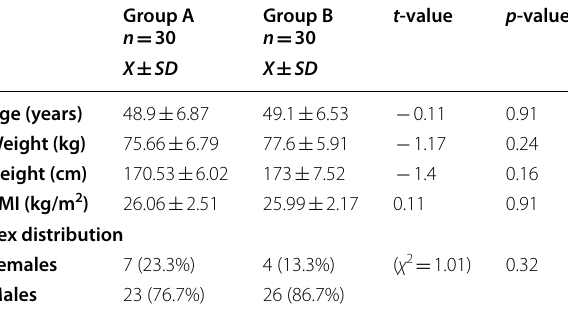
SD Standard deviation, χ 2 Chi squared value, p value Probability